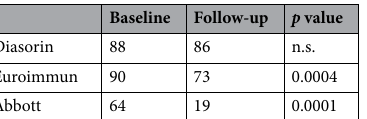
Table 4. Seroprevalence: development of antibodies from baseline to follow-up.